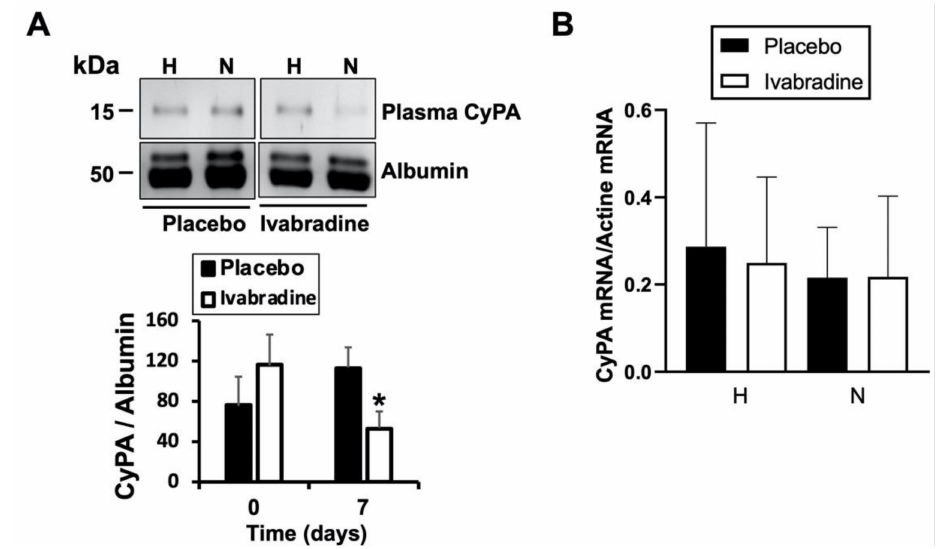
Figure 3. Ivabradine reduces plasma CyPA after IR. ( A ) Immunoblot detection of CyPA and albumin as loading control in plasma samples from placebo- and Ivabradinetreated pigs subjected to IR ( n = 9 Ivabradine/8 placebo. Mean ± SD; * p < 0.05 d7 placebo vs. Ivabradine). ( B ) mRNA expression from healthy and necrotic sections of hearts subjected to IR in response to Ivabradine or placebo ( n = 9 Ivabradine/8